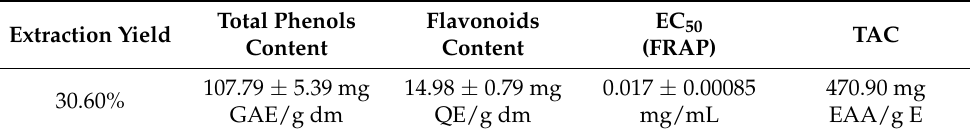
Table 1. Total phenols content, flavonoids content and antioxidant activity of hydroethanolic extract from Origanum compactum .